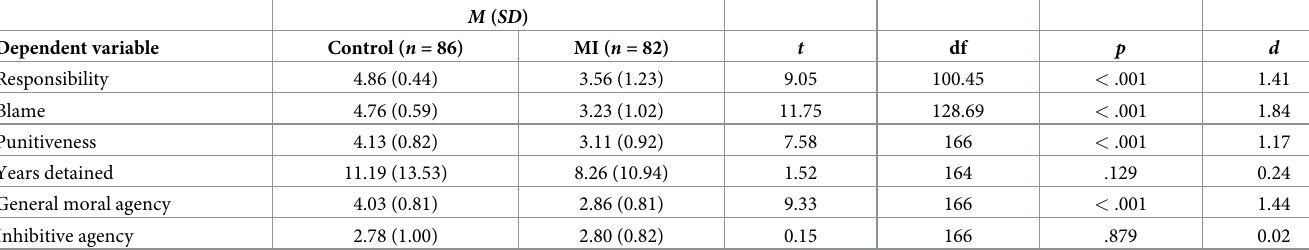
Table 1. Descriptive and t-test statistics for dependent variables at trial (Study 1).